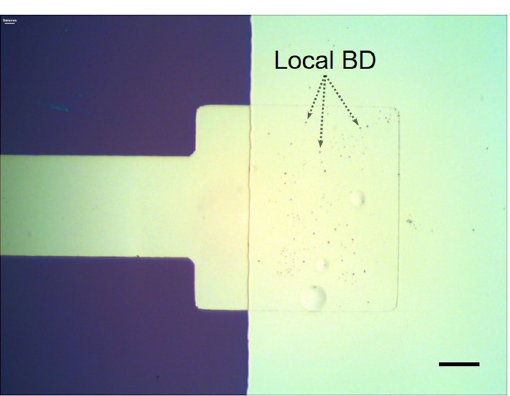
Figure 6. Optical image of a test MDM nanocapacitor after a high-voltage breakdown. Small black specks on the surface of the top electrode constitute local breakdowns (marked as “Local BD”). Scale bar corresponds to 20 μ